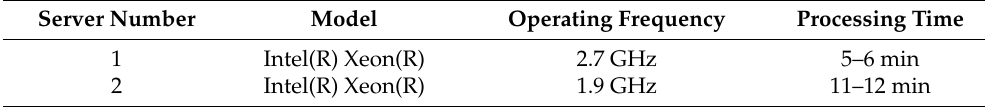
Table 6. Processing time of BLS POD on different